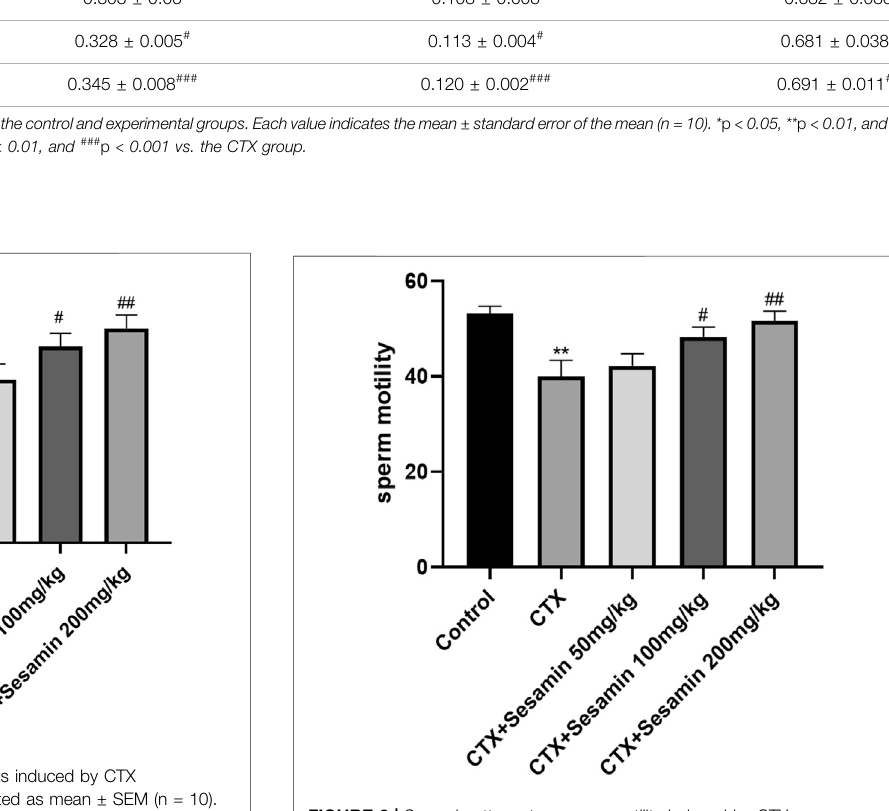
FIGURE 2 | Sesamin attenuates sperm motility induced by CTX exposure in ICR mice. The results are presented as mean ± SEM (n (cid:2) 10). * p < 0.05 and ** p < 0.01 as compared with the control group; # p < 0.05 and ## p < 0.01 as compared with the CTX